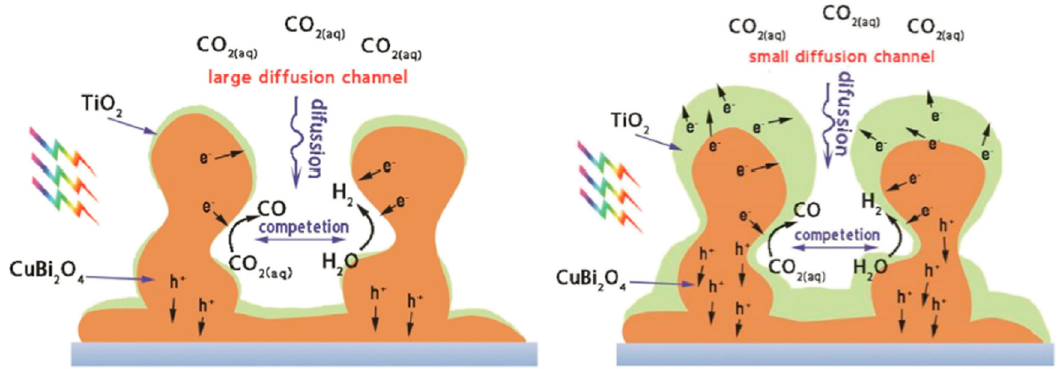
Figure 13: E ff ect of mesostructure on activity and selectivity of CuBi 2 O 4 /TiO 2 nanocomposite for PEC reduction of CO 2 . ( Reprinted with permission from ref. [ 191 ] . Copyright © 2021, Elsevier )